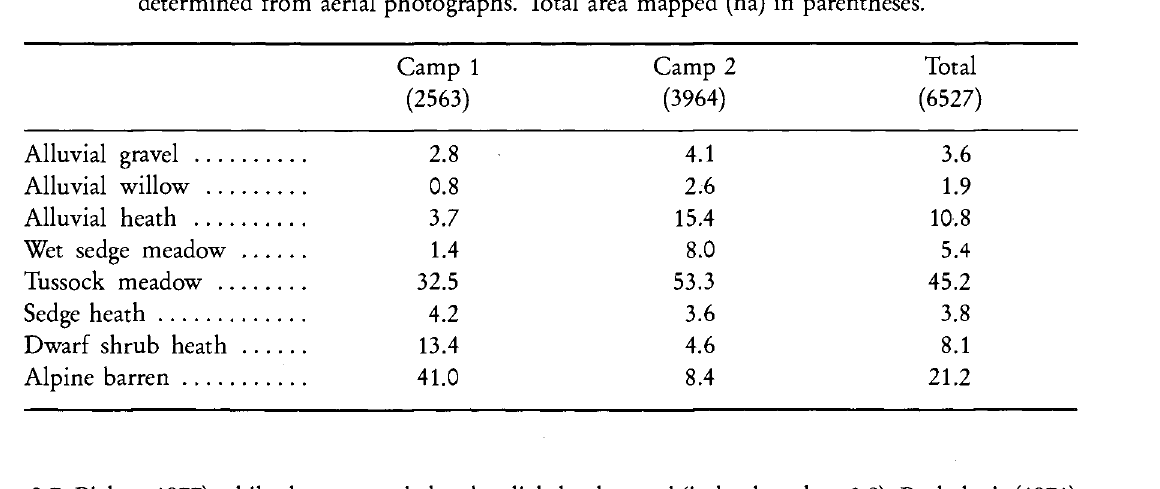
Table 3.2. Percent coverage of range types on the calving grounds of the Porcupine Caribou Herd as determined from aerial photographs. Total area mapped (ha) in parentheses.